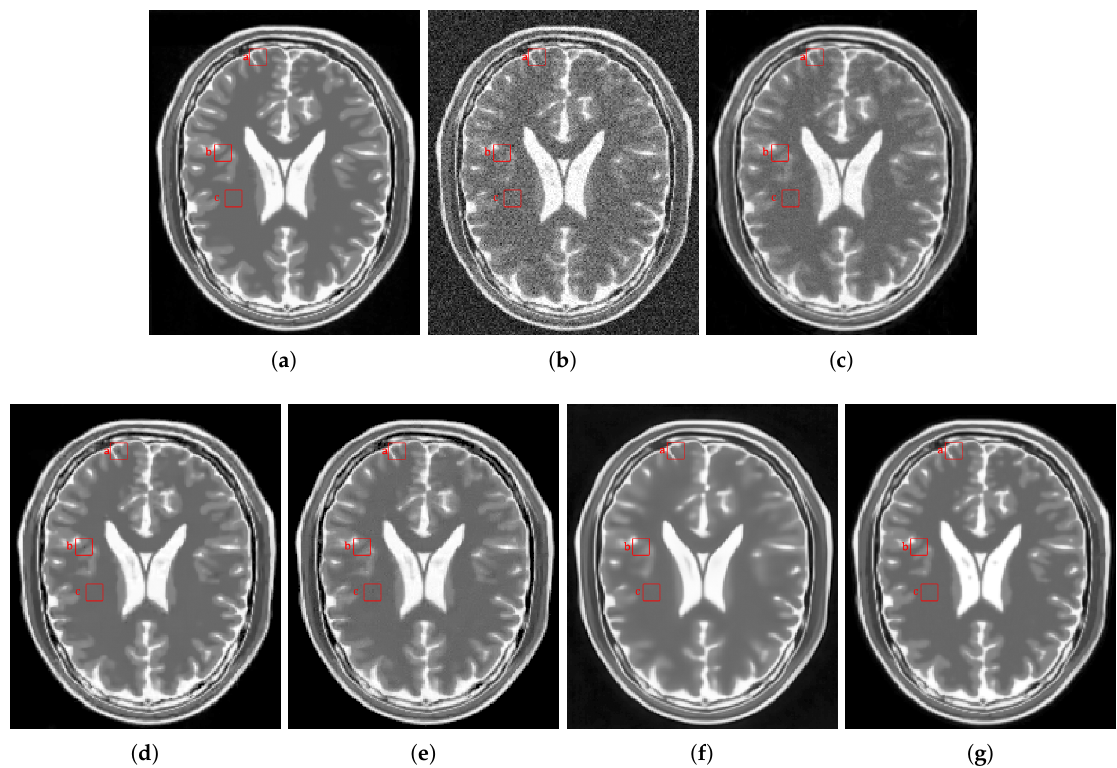
Figure 12. Comparison of the denoising methods on the T2w synthetic noise-free MR image corrupted with 7% Rician noise. ( a ) Original synthetic noise-free MR image. ( b ) Original image corrupted with 7% Rician noise. ( c – g ) Denoising results of the KSVD, the PRINLM, the BM4D, the DnCNN and the NLSD